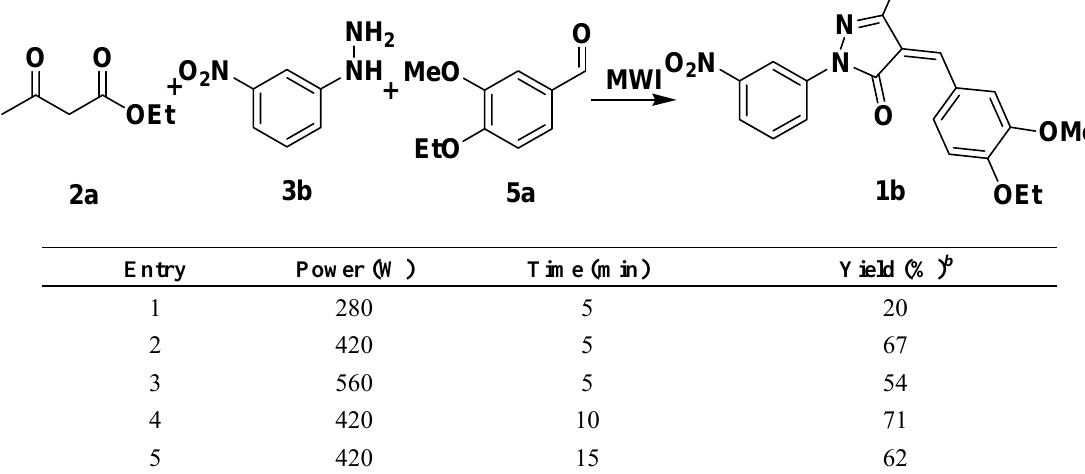
Table 1. Optimization of the power of microwave oven and time of irradiation. a